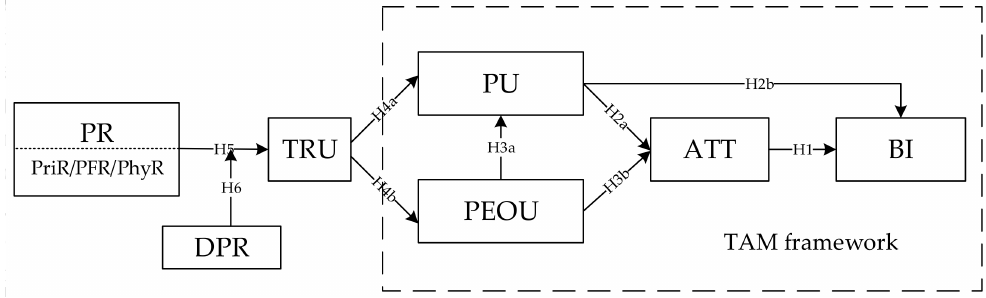
Figure 1. Research Model. (“H” in the model diagram refers to the research “hypothesis”). Note: Perceived Usefulness (PU); Perceived Ease-of-Use (PEOU); Doctor–Patient Relationship (DPR); Perceived Risk (PR); Perceived Privacy Risk (PriR); Perceived Financial Risk (PFR); Perceived Physical Risk (PhyR); Attitude (ATT); Behavioral Intention (BI); Trust